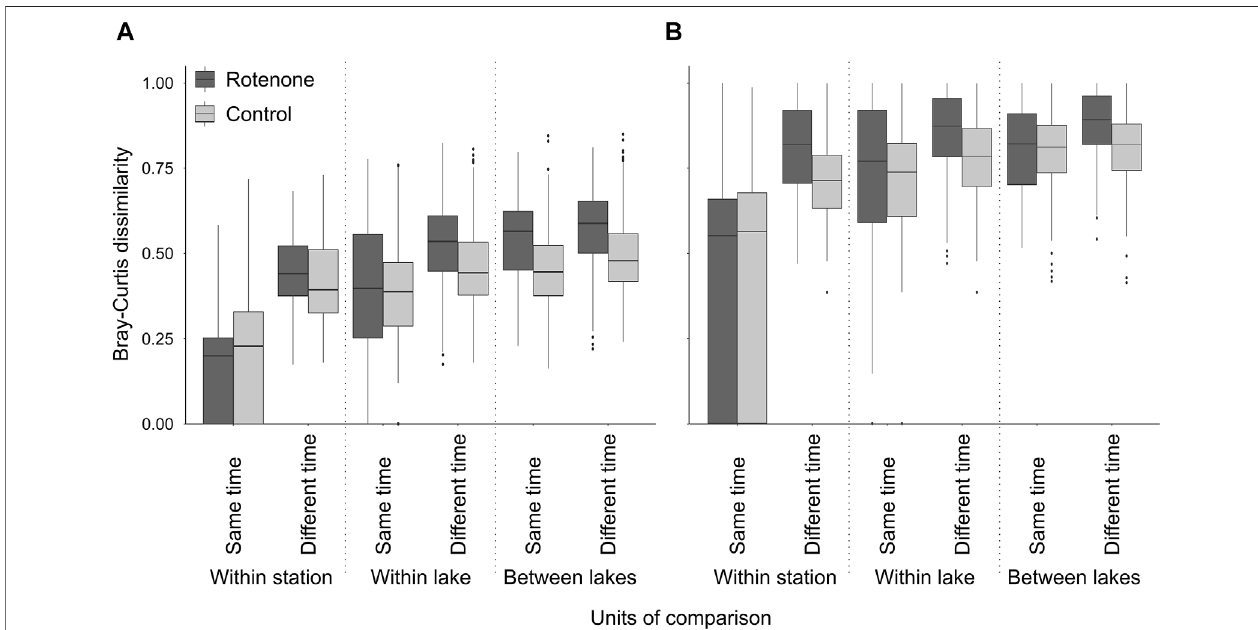
FIGURE 5 | Pairwise Bray-Curtis dissimilarity values of rotenone treated lakes and control lakes. For morphological identi fi cations (A) . For identi fi cations based on metabarcoding of peDNA (B) . The horizontal line in each box represents the median, the boxes depict the 1st to the 3rd quartile and the blind end of the whiskers representthemaximumand minimumvalues,except outlierswhicharemarkedwithdots.Thestippled linedifferentiatestheunitsofcomparisons(within stations, within lakes and between lakes).